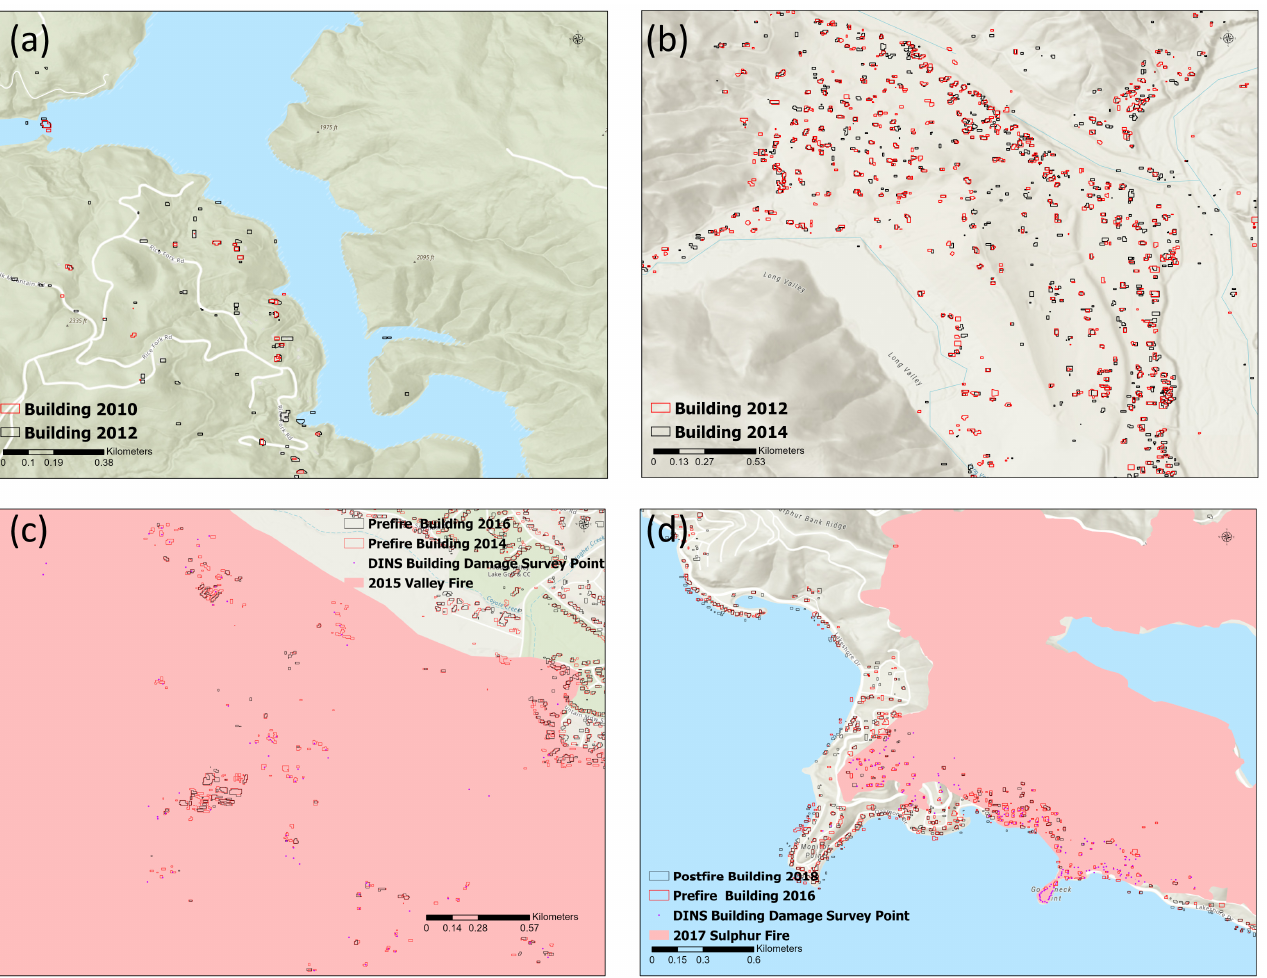
Figure 7. Examples of tracking building dynamics: ( a , b ) newly built houses (in black) during 2010–2014 and ( c , d ) destroyed buildings (in red) by wildfires during 2015-2018 in Lake County. The 2010 buildings were shown at the top in red ( a , b ) and 2018 postfire buildings in black ( c , d ). The damaged buildings from the DINS survey were shown in purple for comparison ( c , d ). Refer to yellow bounding boxes in Figure 6d for the locations of these four examples.